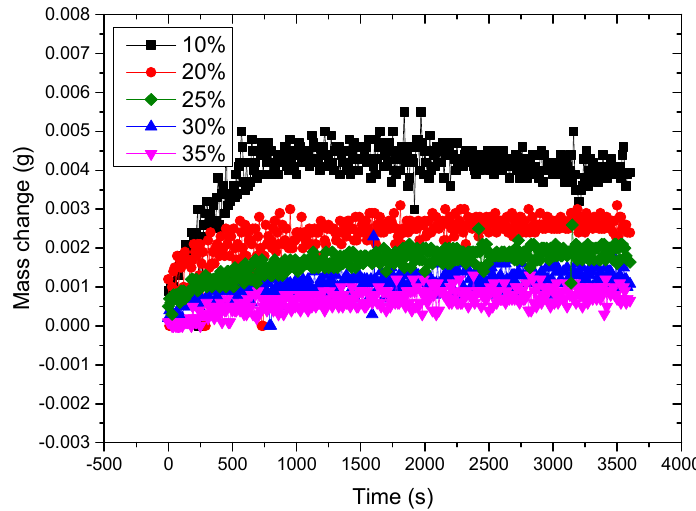
Figure 11. Evaporation rates of LiCl solution with the solar steam structure material (20 mL).